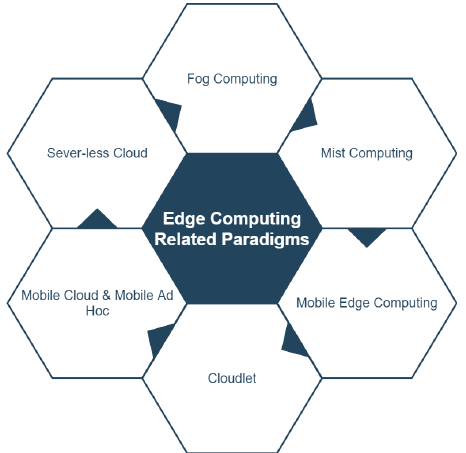
Figure 2. Different closely related concepts to the paradigm of edge